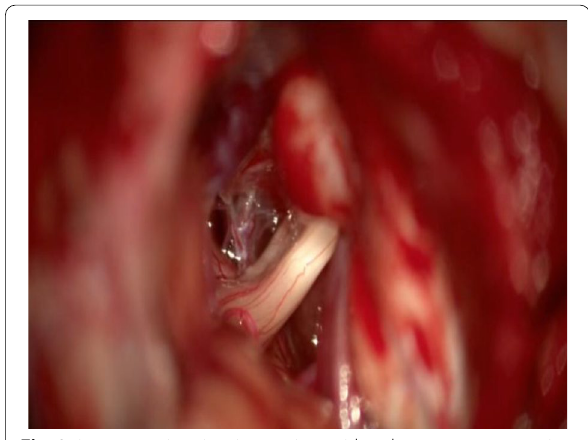
Fig. 3 intraoperative view in a patient with only venous compression found at the root entry